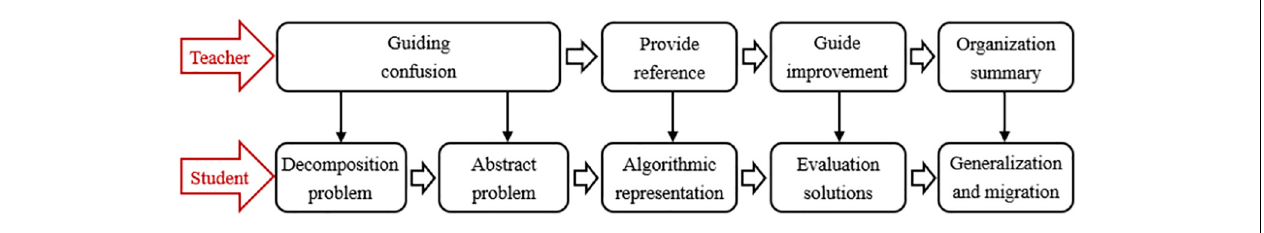
FIGURE 1 | Problem-oriented learning model.